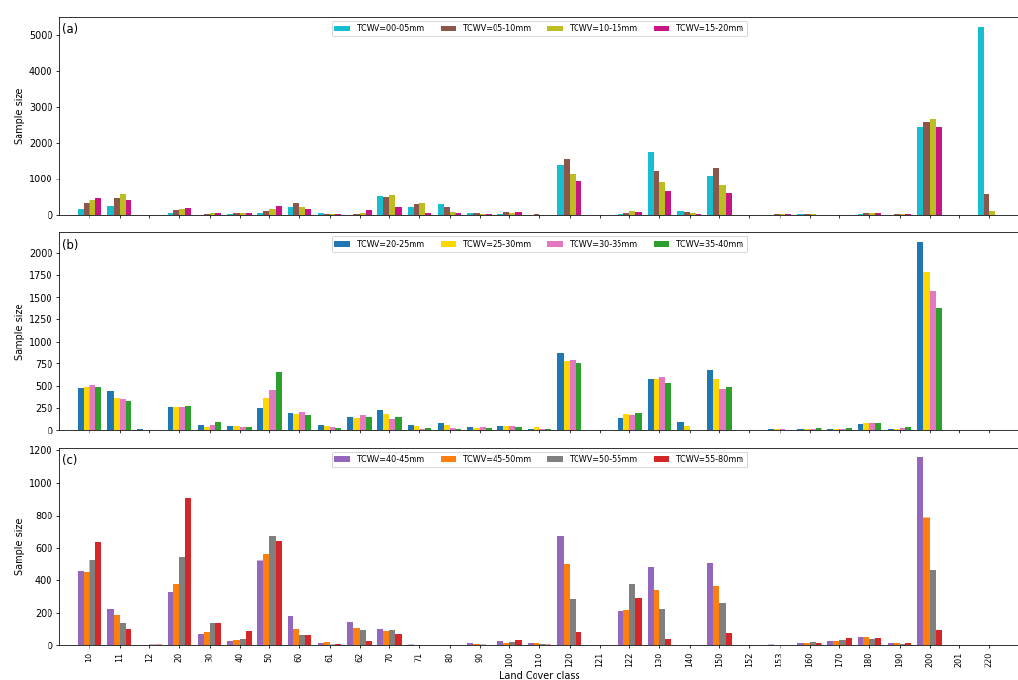
Figure 8. Histograms of Landcover types (as described in Table 1) in the calibration database for each TCWV class (( a ) 0–5, 5–10, 10–15 and 15–20 mm; ( b ) 20–25, 25–30, 30–35 and 35–40 mm; ( c ) 40–45, 45 – 50, 50 – 55 and 55 – 80 mm).